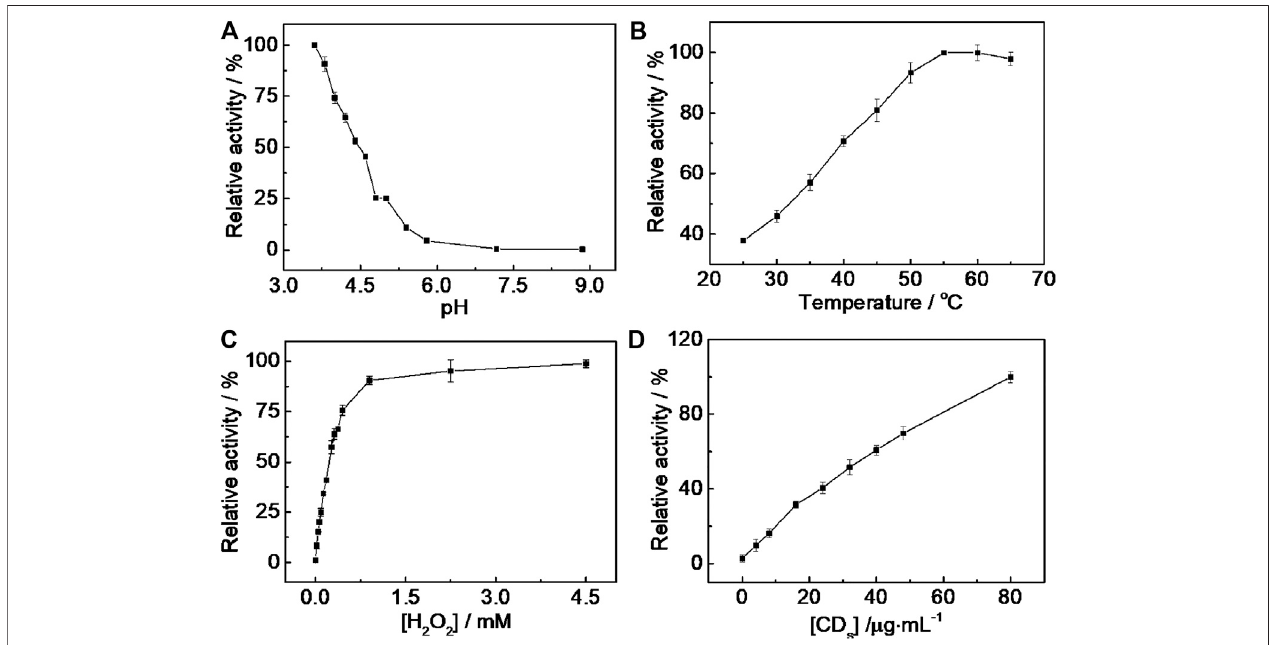
FIGURE 4 | pH (A) , temperature (B) , H 2 O 2 concentration (C) , and CD-phenylalanine concentration (D) dependent peroxidase-like catalytic activity of CD- phenylalanine toward the TMB – H 2 O 2 system. The maximum point in each curve (A – D) was set to 100%.